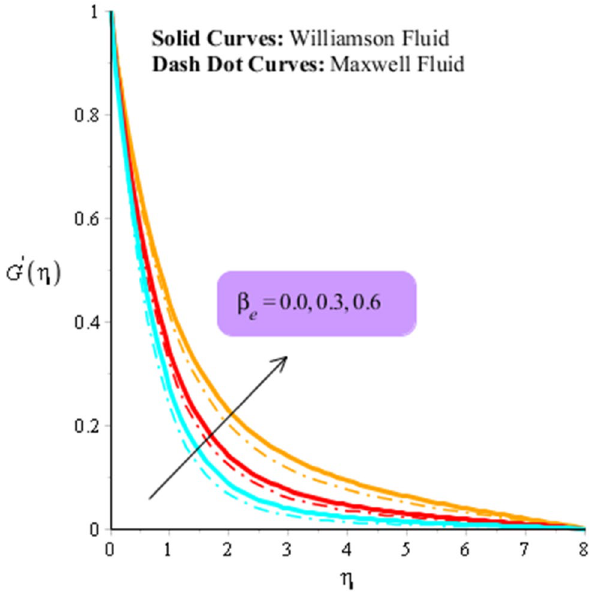
Figure 8. Influence of β e versus secondary velocity filed.